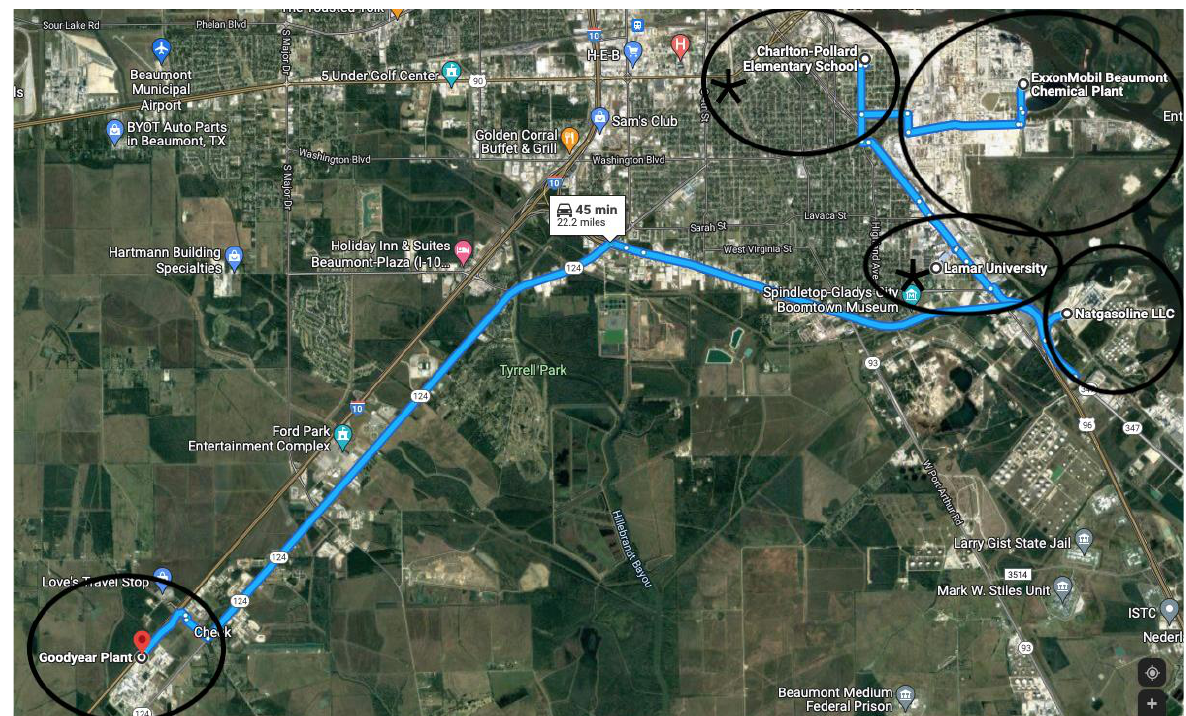
Figure 1. Map of Beaumont, Texas showing industries and location of two air monitors. The two stars on the map denote Beaumont Downtown (located within the Lamar University circle) and Beaumont Mary (located within the Charlton Pollard Elementary circle).